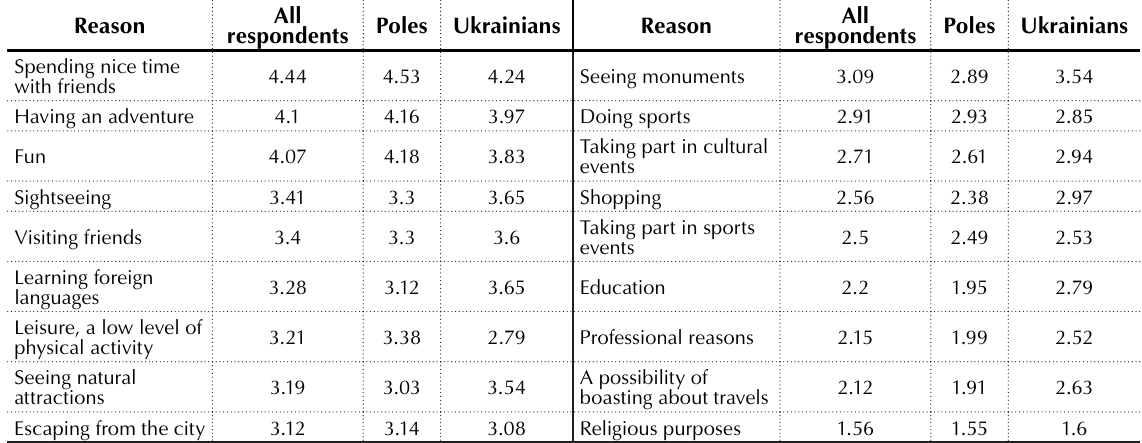
Table 3. Reasons for tourist trips